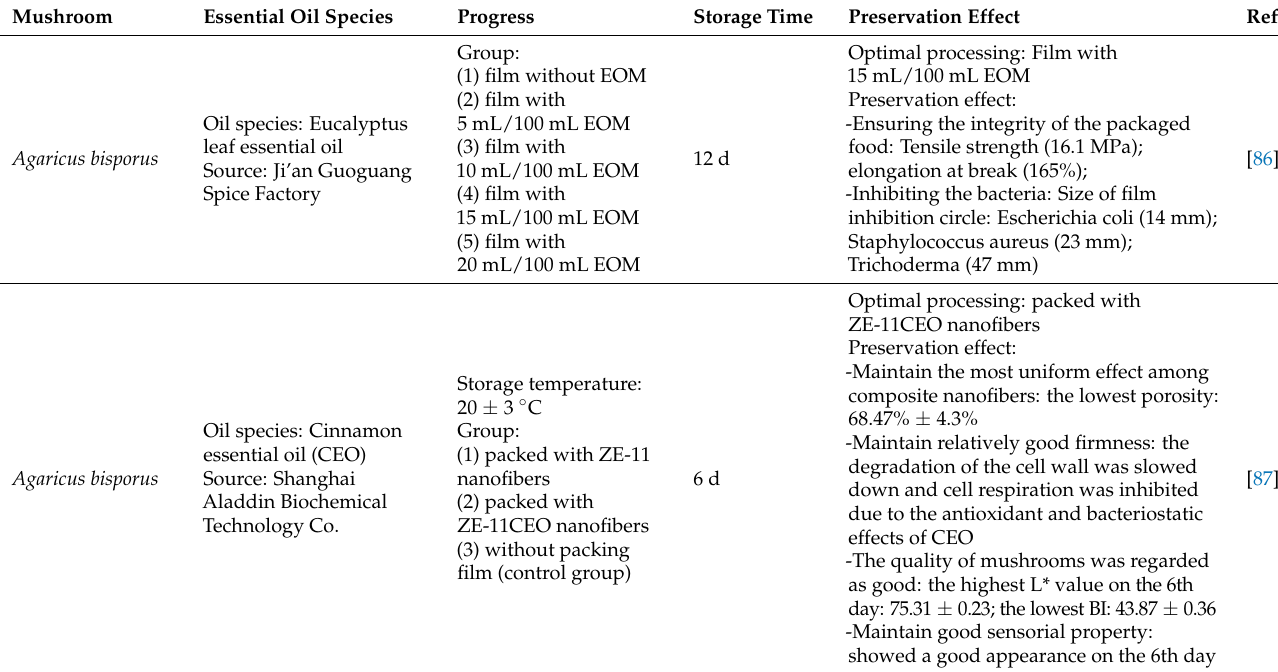
Figure 2. Forms of essential oils applied to the preservation of edible mushrooms (( I ) Schematic diagram of the formation of an essential oil slow-release system and its application form in the preservation of edible mushrooms; ( II ) the main components of essential oils used to preserve edible mushrooms; ( III ) changes in edible mushroom quality after essential oil treatment. ( A ) Agaricus bisporus after chi- tosan/zeaxolysin/lemon essential oil composite film treatment [70]; ( B ) Agaricus bisporus after treatment with cinnamon essential oil [84]; ( C ) Agaricus bisporus after starch/cinnamon essential oil composite film treatment [85]. Copyright 2021, Elsevier.) Figure 2A created with BioRender.com. Table 1. Essential oils (EOs) used for the control of postharvest preservation of